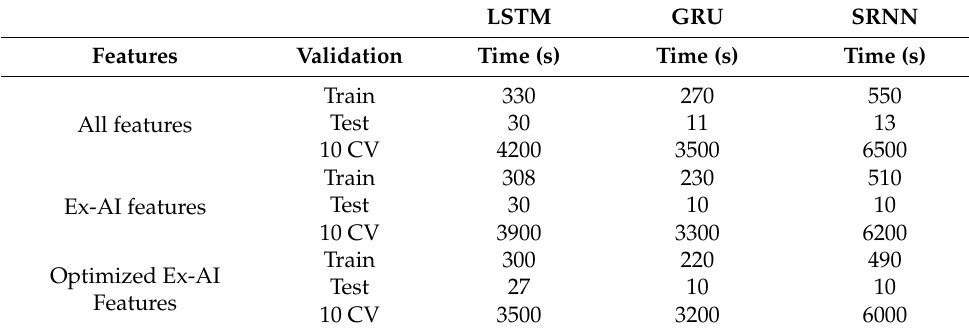
Table 6. Computational time